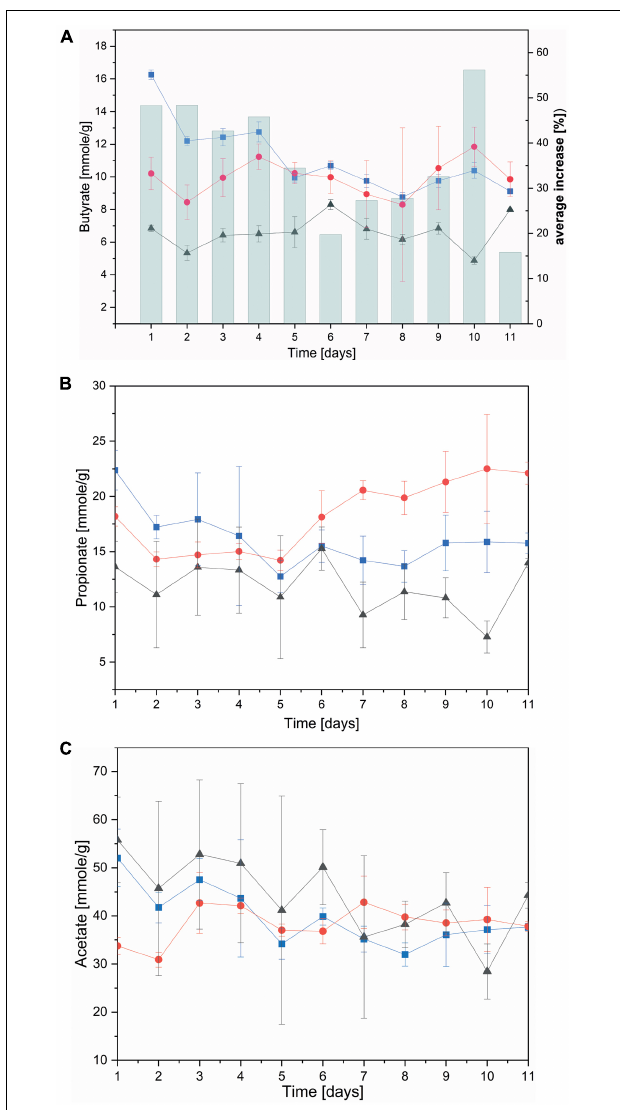
FIGURE 6 | Concentration of short chain fatty acids. Short chain fatty acids were quantified as the average between two fermenter vessels in a continuous flow fermentation system. (A) Butyrate; bars indicate the (%) daily average increase of butyrate compared to nanoparticle-free control fermentation; (B) propionate; (C) acetate. Black: control without nanoparticles added, Blue: non-functionalized nanoparticles, Red: dual-fusion PeiR nanoparticles. Error bars indicate standard errors as averaged over days and fermentation